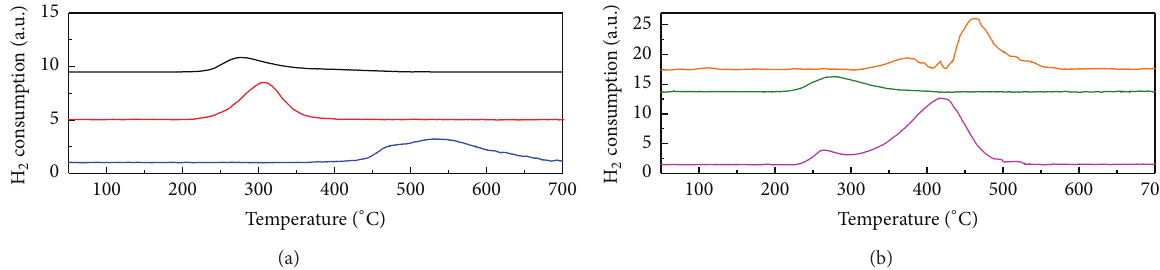
(blue line), Pt-Re/ 𝛾 -Al 2 O 3( (red line), and Pt/ 𝛾 -Al 2 O 3( (black d ) d ) d )